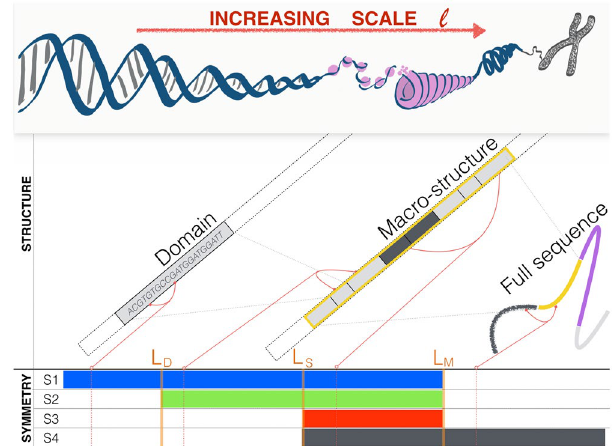
Figure 5. Structure and symmetry at different scales: domain model. Structure and symmetry at different scales  of genetic sequences can be explained using a simple domain model. Our model considers that the full sequence is composed of macro-structures (of size L M ) made by the concatenation of domains (of average size L D < L M ), which are themselves correlated with neighbouring domains (up to a scale L D < L S < L M ). The biological processes that shapes domains imposes that, in each macrostructure, the types of domains comes in symmetric pairs. As a consequence, we show that four different symmetries S 1 – S 4 are relevant at different scales  (see text for